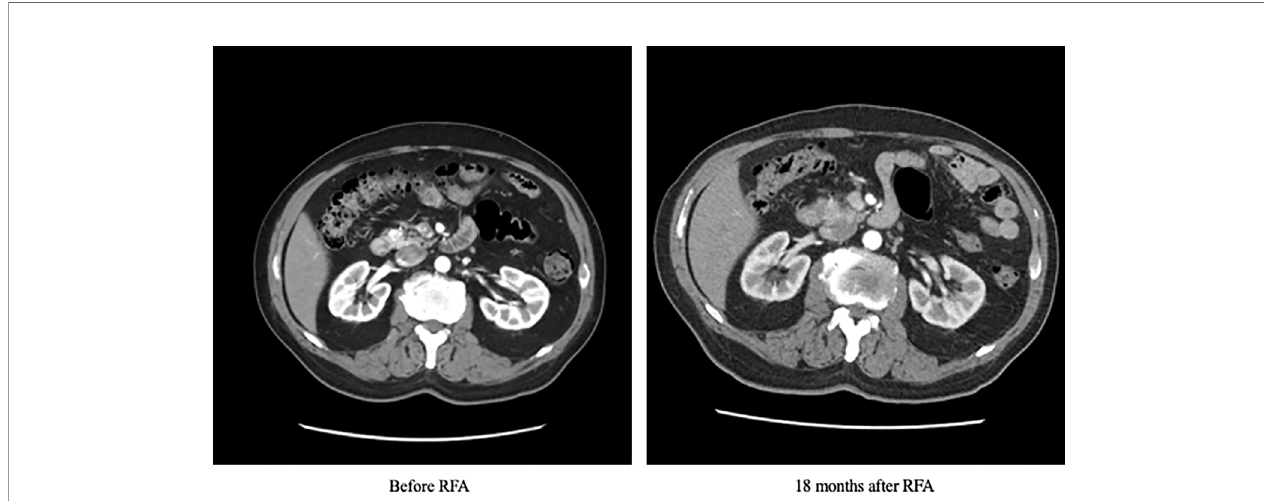
FIGURE 4 | Contrast CT scan of the patient at baseline and 18 months after RFA. CT, computed tomography; RFA, radiofrequency